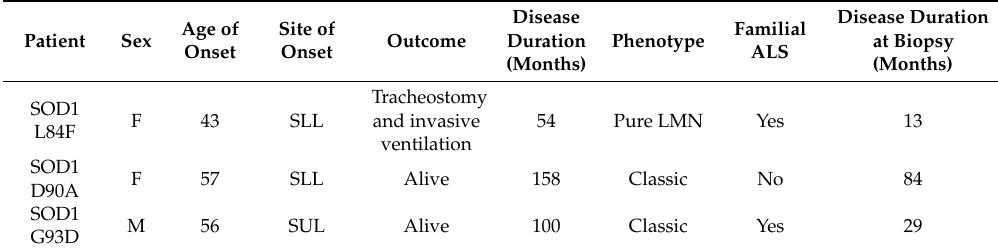
Table 1. Clinical and demographic characteristics of